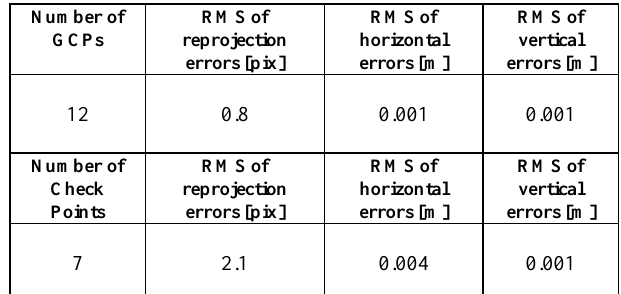
Fig. 3. Two images of the wall captured with the front facing camera (top), the sequence of images, control points and check points (middle), and a detail of the extracted mesh for a portion of the wall (bottom).